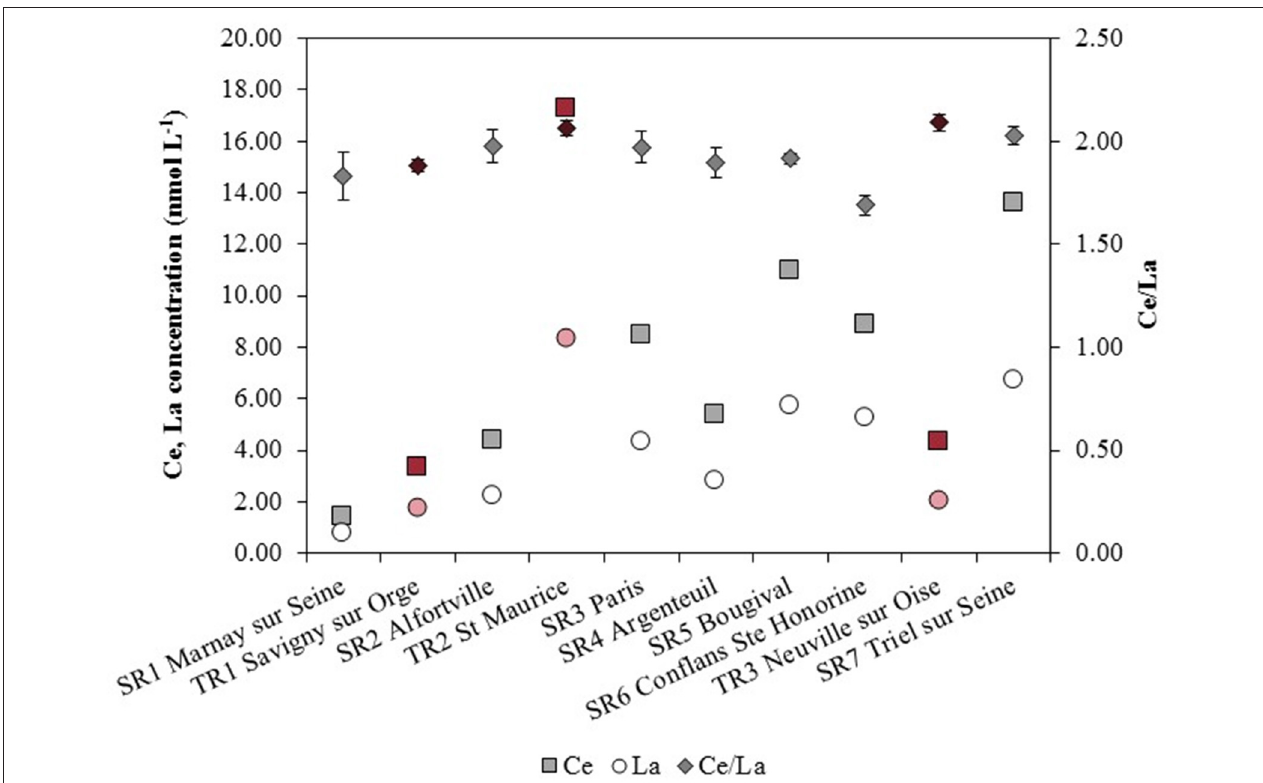
FIGURE 3 | Ce and La total concentrations (left-hand side axis) and Ce/La elemental ratios (right-hand side axis) as a function of the different sampling sites from SR1 to SR7 (in gray), with the three different tributaries (in